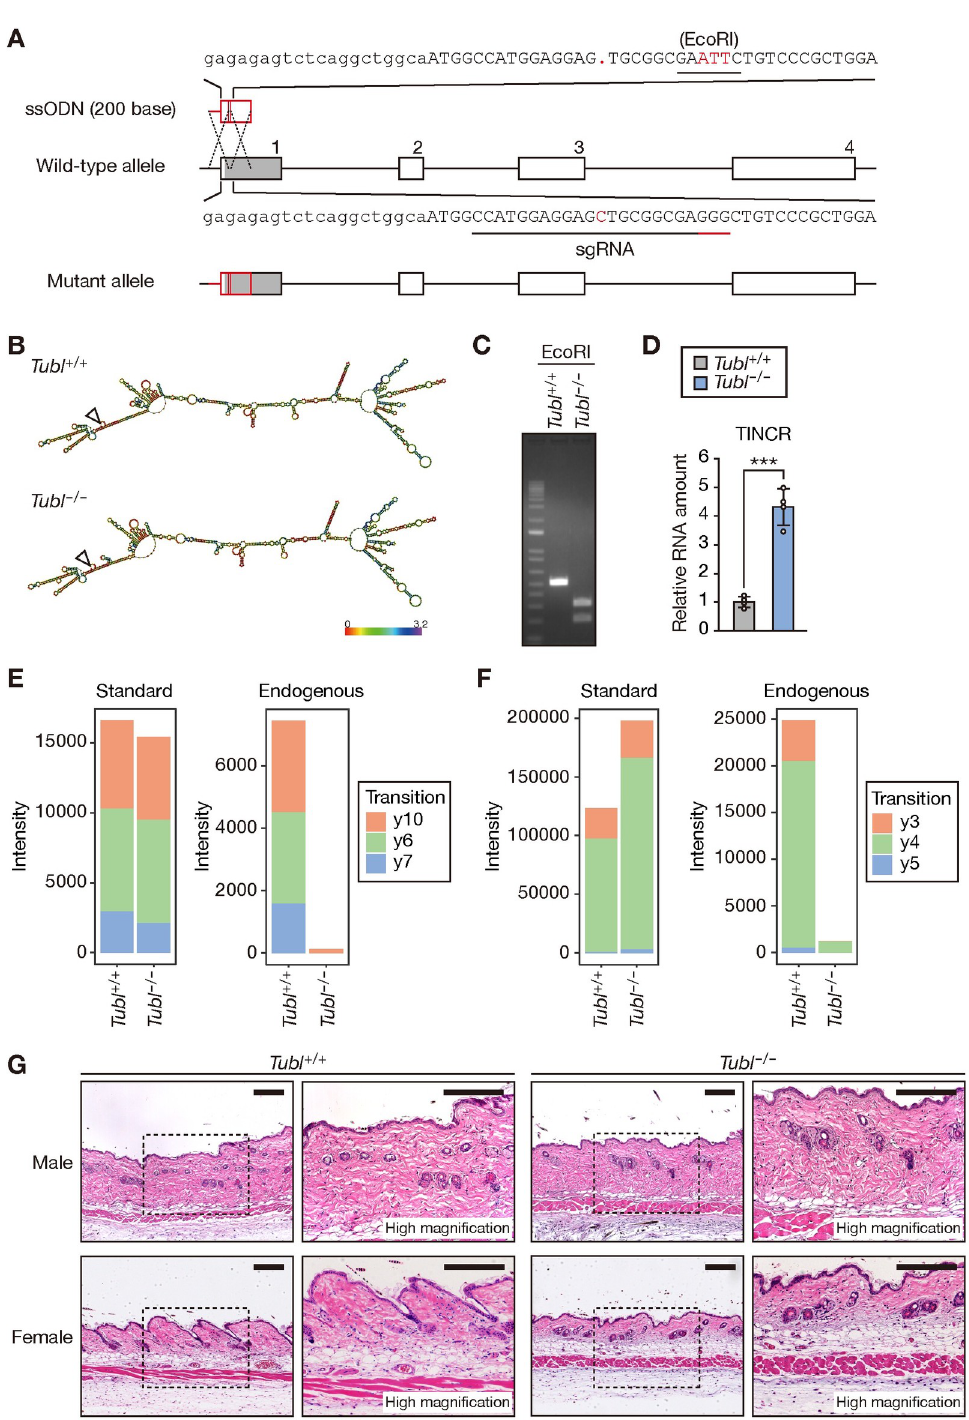
Fig 4. Generation of TUBL-deficient mice. (A) Schematic representation of the WT TINCR allele, the single-stranded oligodeoxynucleotide (ssODN), and the mutant allele after homologous recombination. Exons are denoted by numbered boxes. The single guide RNA (sgRNA) for the CRISPR-Cas9 system and its protospacer adjacent motif (PAM) are indicated by contiguous black and red underlines, respectively. The TUBL ORF is represented by the gray shading in the box corresponding to exon 1 of TINCR . (B) Predicted secondary structure and minimal free energy for WT TINCR and the mutant form generated by the CRISPR-Cas9 system for establishment of Tubl − / − mice. The triangle indicates the 5’ end of the transcript. (C) PCR analysis of genomic DNA from the tail of mice of the indicated genotypes. The